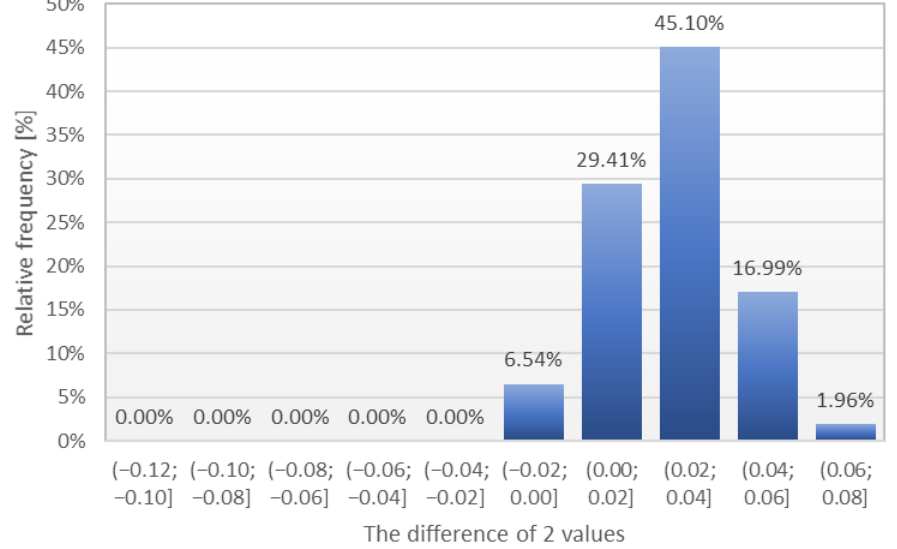
Figure 21. Distribution plot of differences between measurement by methods (right side of arch support frame). Table 1. Statistical tests for normality (left side of arch support frame).